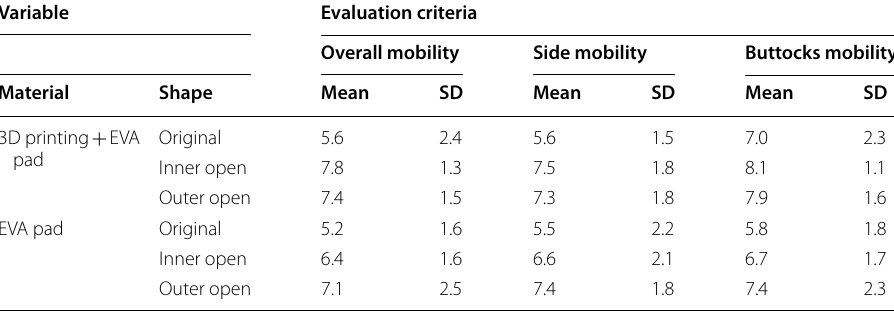
Table 7 Mean and SD of subjective comfort depending on material and shape (N